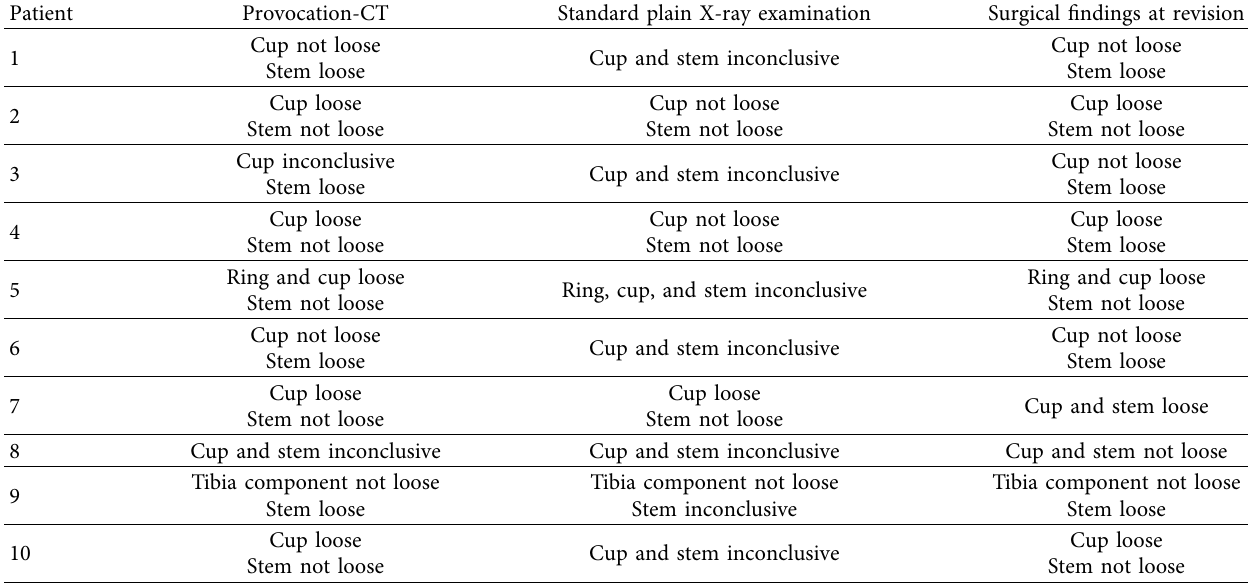
Table 2: Individual results from provocation-CT, standard plain X-ray examination, and surgical findings at revision.